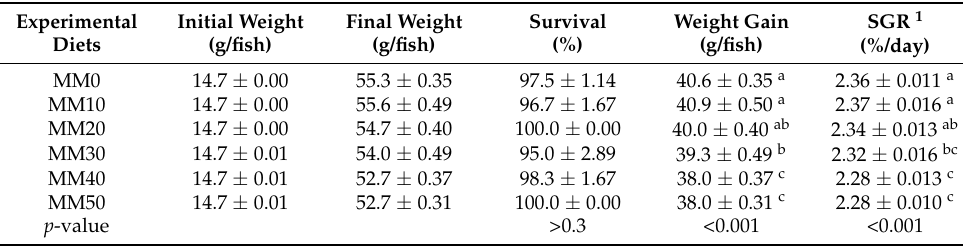
Table 2. Survival (%), weight gain (g/fish), and specific growth rate (SGR) of olive flounder fed experimental diets for 56 days.